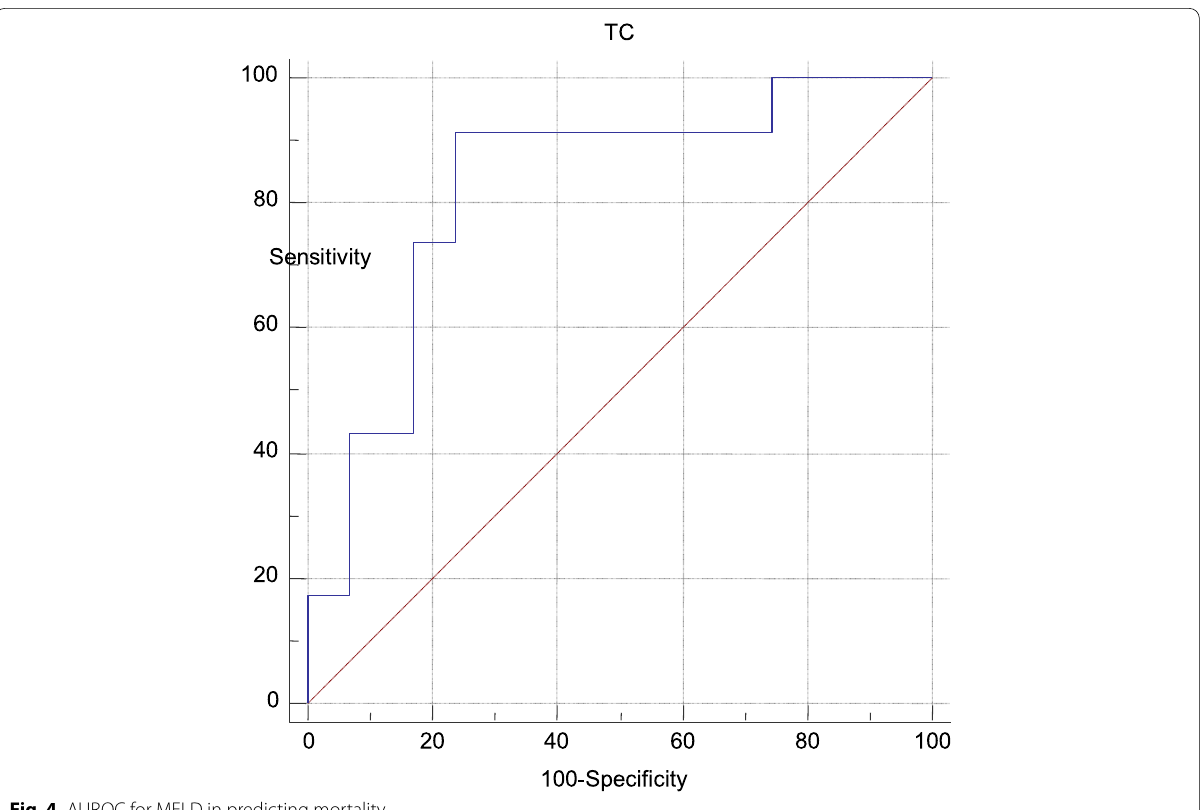
Fig. 4 AUROC for MELD in predicting mortality